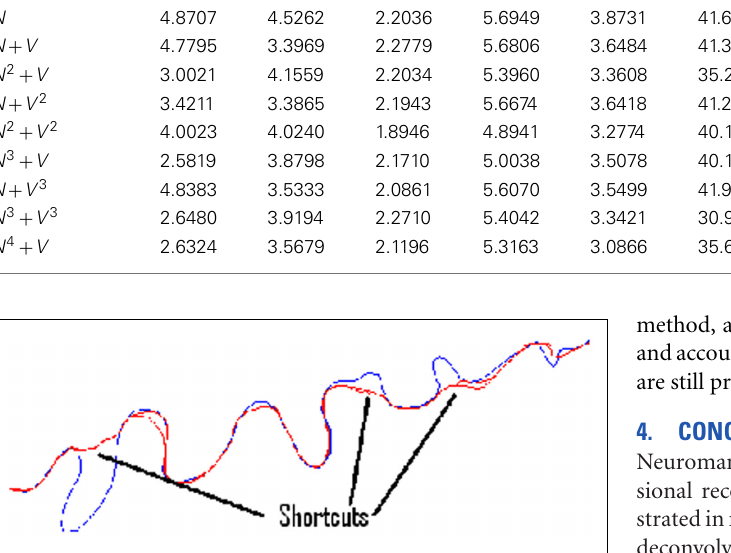
FIGURE 6 |The ground-truth tracing for benchmark neurite 10 (rotated 90˚ anticlockwise), along with examples of the tracing errors caused by taking shortcuts.